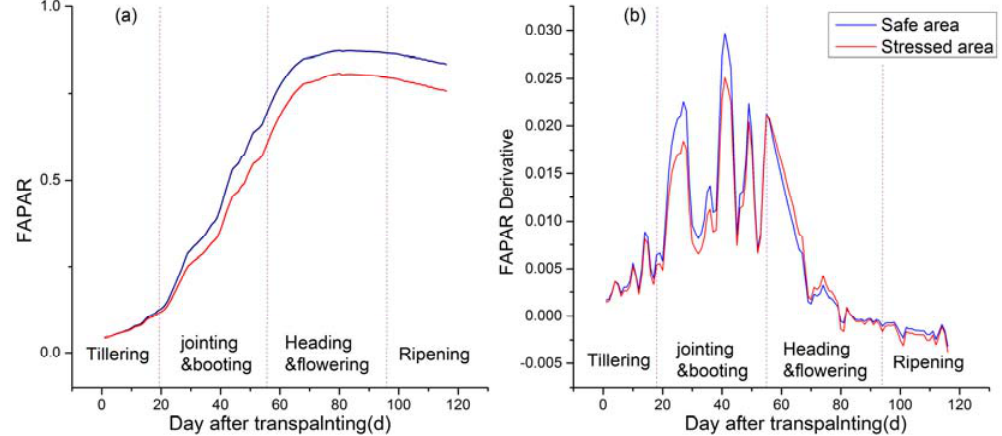
Figure 6. ( a , b ) Seasonal variations of FAPAR in paddy rice growth period under different heavy metal stress area. stress